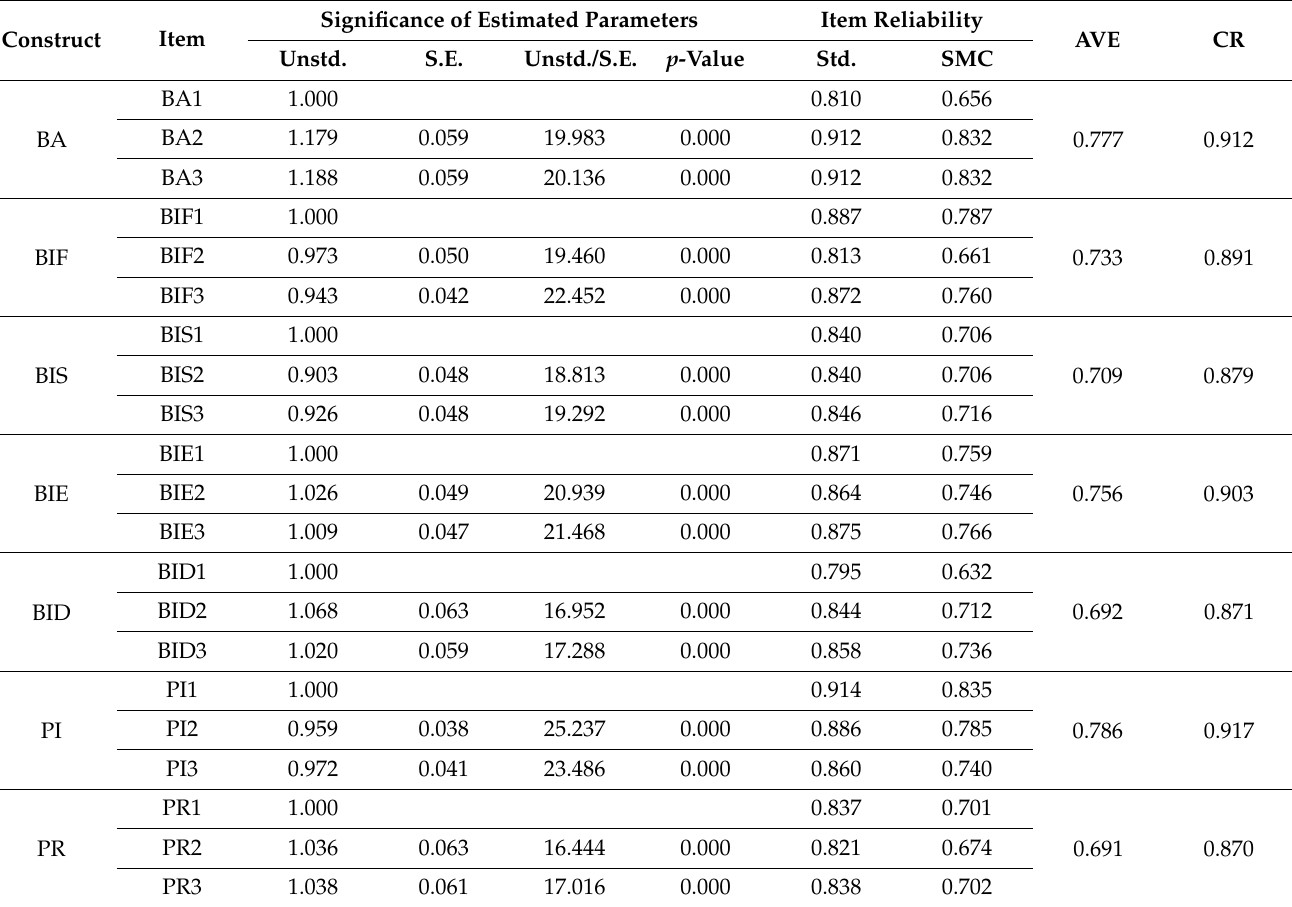
Table 7. The results of the Measurement